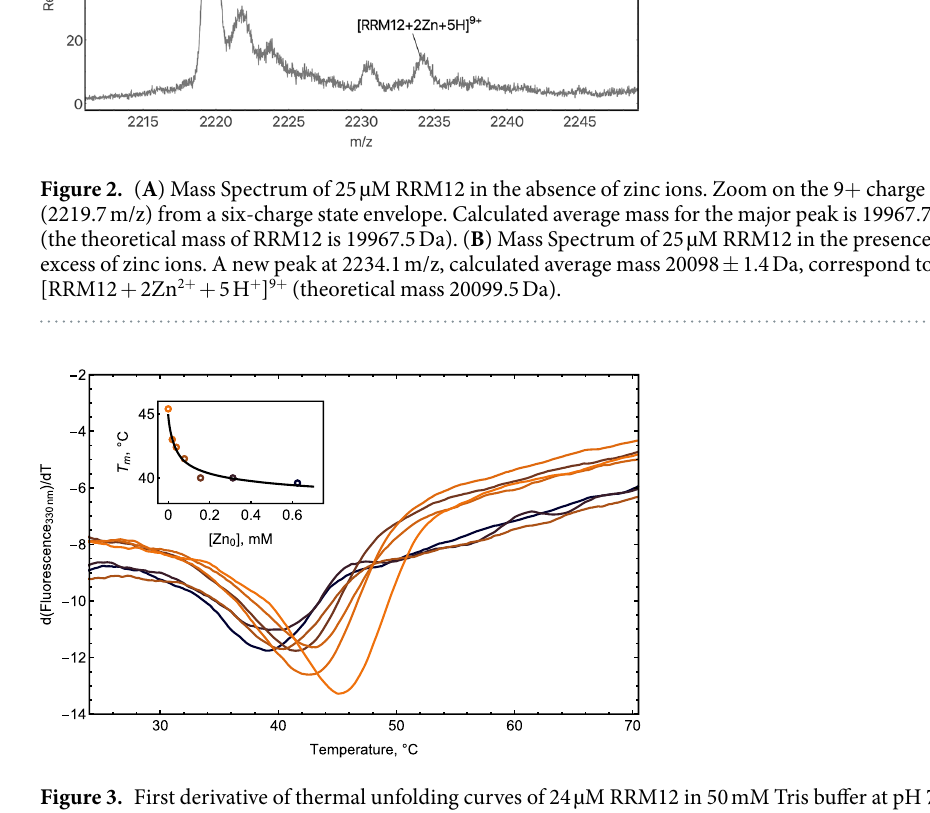
Figure 3. First derivative of thermal unfolding curves of 24 µ M RRM12 in 50 mM Tris buffer at pH 7.3 obtained using Prometheus NT.Plex instrument (NanoTemper Technologies GmbH) in the presence of zinc ions at 0; 20; 39; 78; 156; 310; 625 μ M (shown in colors from orange to black). Insert: Denaturation temperatures T m plotted vs. total zinc concentration [ Zn 0 ] in circles and best fit as solid black